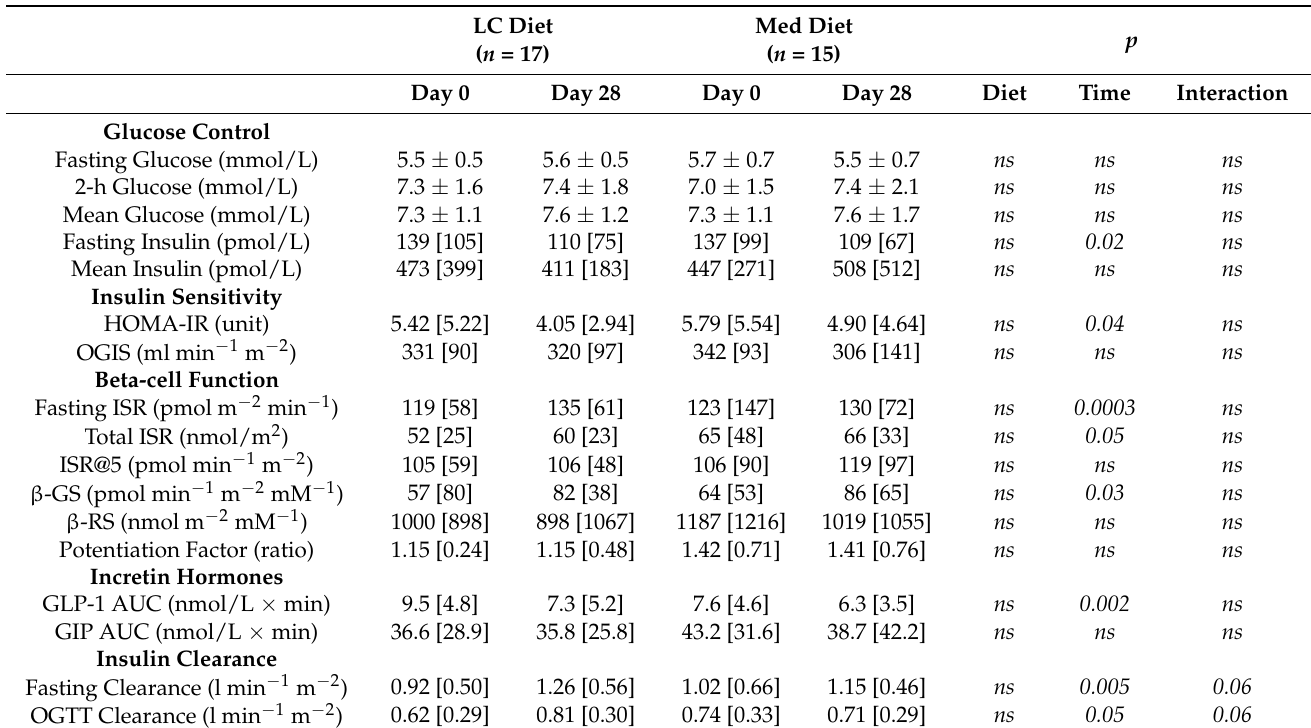
Table 3. Changes in glucose and insulin metabolism induced by a low-carbohydrate diet (LC) or Mediterranean (Med) diet in morbidly obese